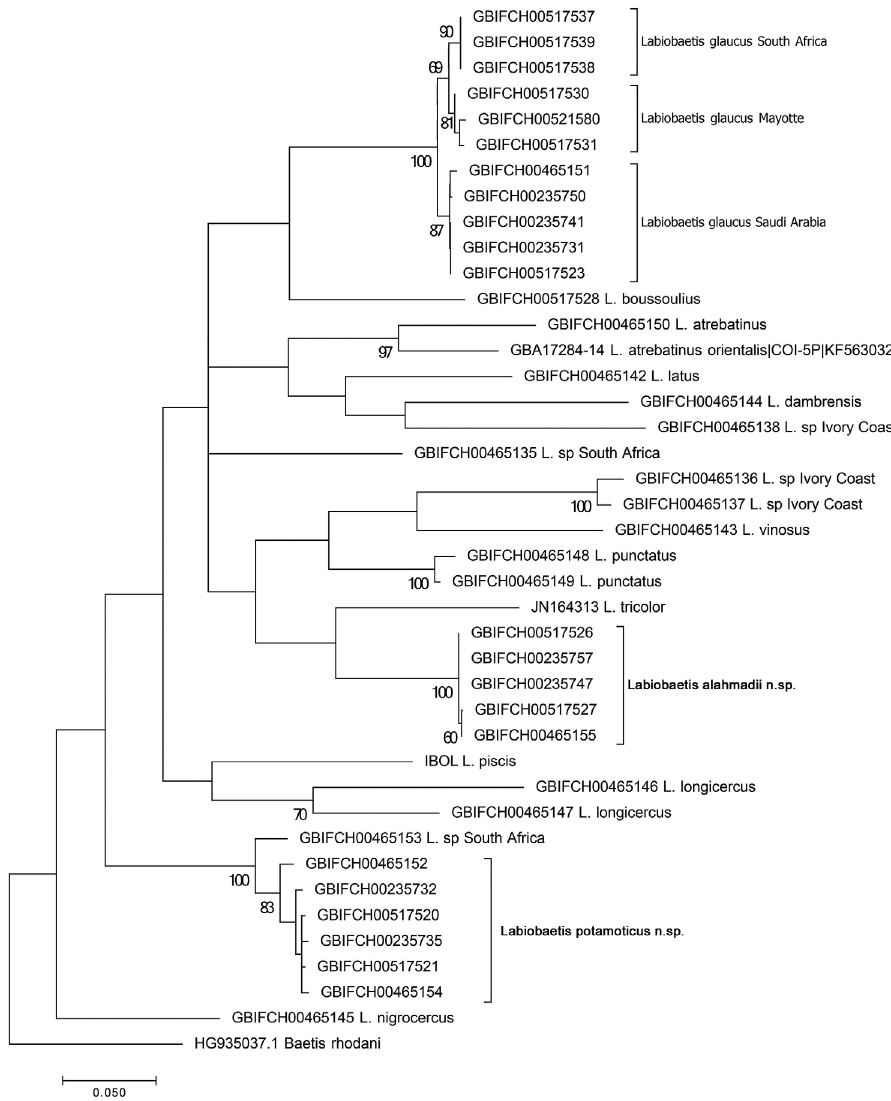
Figure 53. Maximum Likelihood (ML) consensus tree reconstructed for 40 haplotypes of Labiobaetis spp. Tree drawn to scale, branch lengths measured in number of substitutions per site, deeper nodes la- belled above branches with Maximum Likelihood bootstrap support